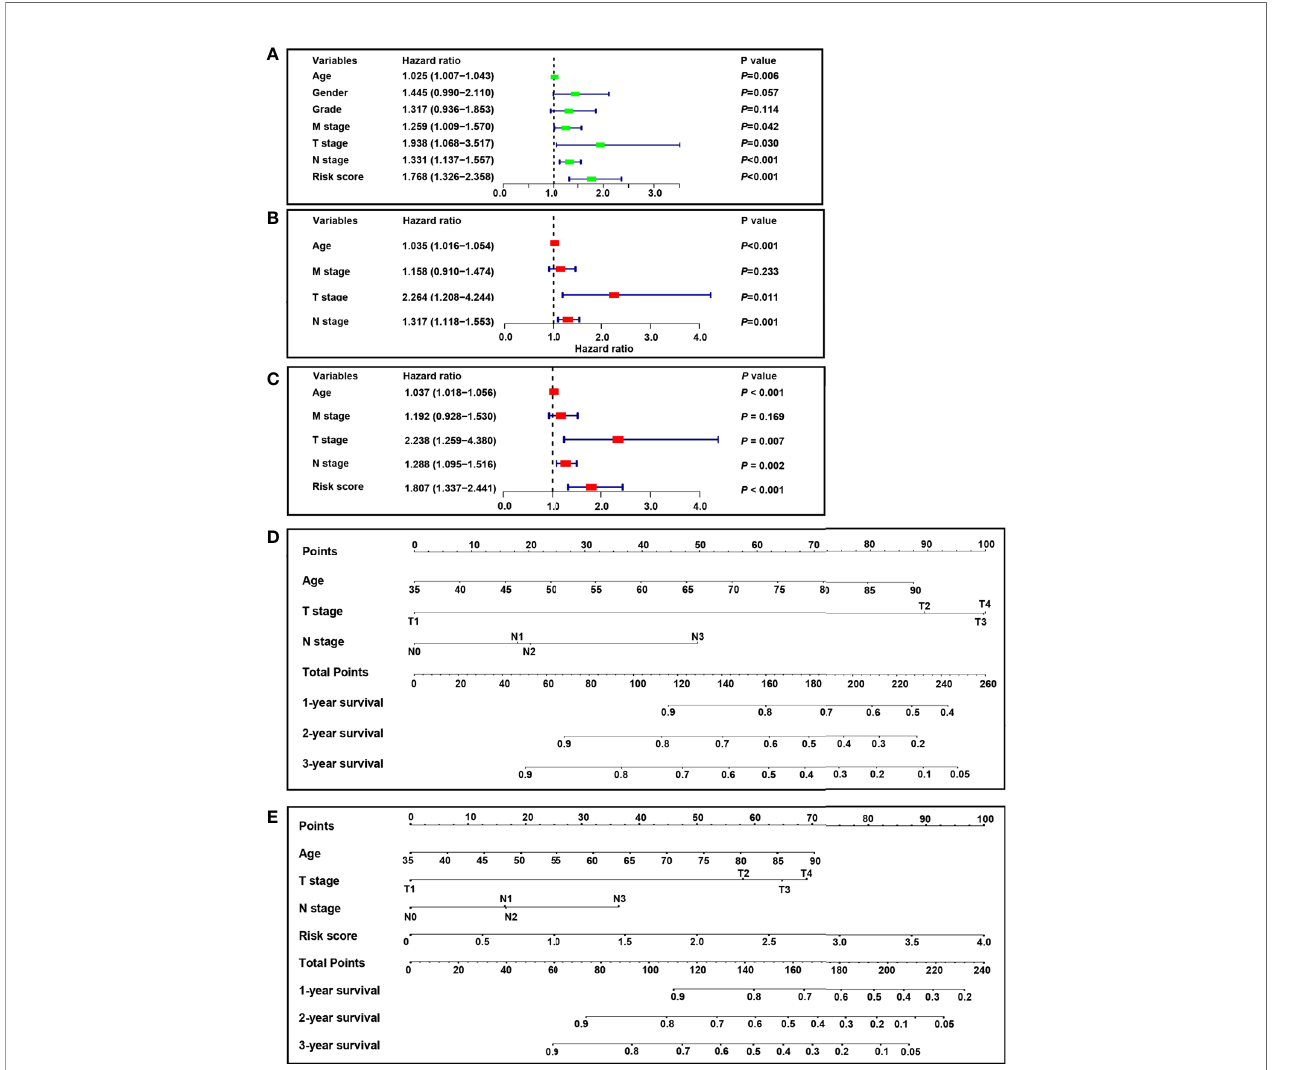
FIGURE 8 | Construction of nomograms. (A) Univariate analysis included risk score, age, gender, grade, M stage, T stage and N stage in the screening cohort. (B) Cox proportional hazards analysis included age, M stage, T stage and N stage in the screening cohort. (C) Cox proportional hazards analysis included risk score, age, M stage, T stage and N stage in the screening cohort. (D) Nomogram 1 based on the clinicopathological characteristics. (E) Nomogram 2 based on the risk score and clinicopathological